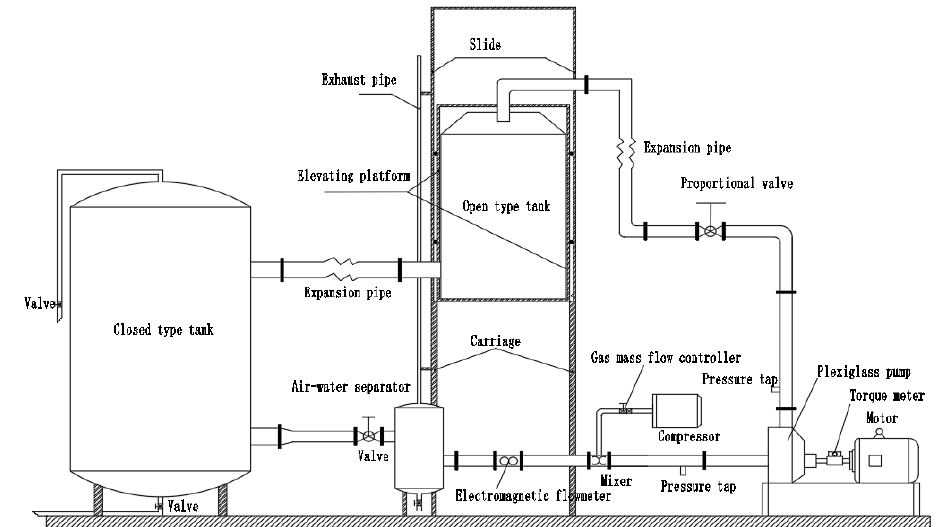
Figure 1. Experimental design of two-phase research on centrifugal pump.